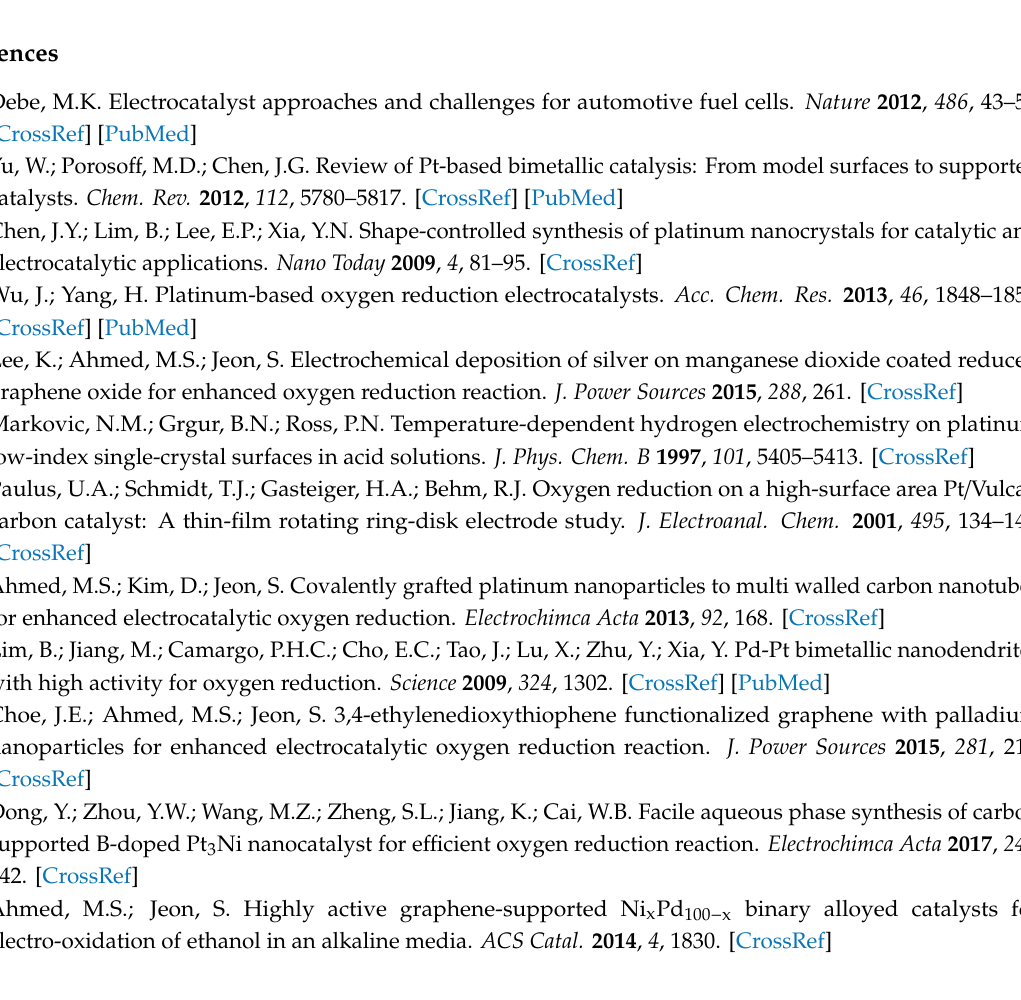
Figure S1: XPS survey spectra for Pt / C, Pt / C 8 :G 2 , Pt / C 6 :G4 and Pt / C 1 :G 9 samples. Figure S2: C 1s XPS spectra for Pt / C (a), Pt / C 8 :G 2 (b), Pt / C 6 :G 4 (c) and G-sheets (d) samples. Figure S3: Pt 4f XPS spectra for Pt / C (a), Pt / C 8 :G 2 (b) and Pt / C 6 :G 4 (c) samples. Figure S4: Curves showing the ORR onset potential for Pt / C 8 :G 2 (a), Pt / C 6 :G 4 (b), Pt / C (c) and G-sheets (d) electrodes. Figure S5: Comparison of MA and SA for Pt / C, Pt / C 8 :G 2 and Pt / C 6 :G 4 electrodes at 0.9 V. Figure S6: LSV curves for ORR at various rpm on G-sheets (a), Pt / C (c), Pt / C 8 :G 2 (e) and Pt / C 6 :G 4 (g) electrodes in an O 2 -saturated 0.1 M HClO 4 electrolyte at a scan rate of 5 mV s − 1 ; the corresponding K-L plots for G-sheets (b), Pt / C (d), Pt / C 8 :G 2 (f) and Pt / C 6 :G 4 (h) at di ff erent electrode potentials. Figure S7: Comparison of TEM images of Pt / C (a, c), and Pt / C 8 :G 2 (b, d) before (a, b) and after (c, d) long-term stability